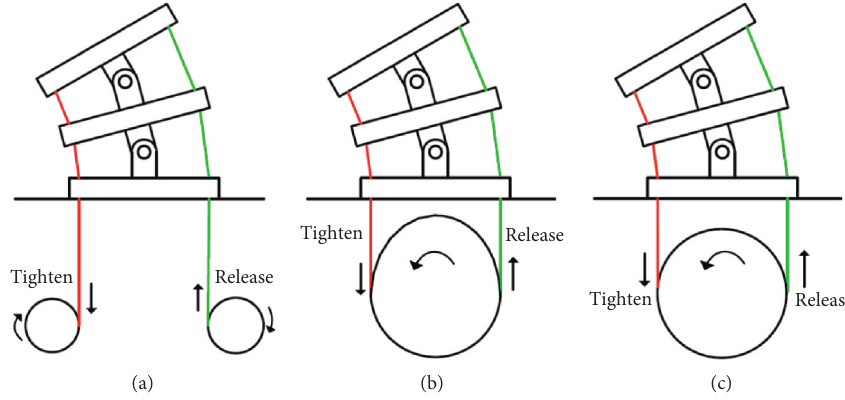
Figure 3: Classic driving system